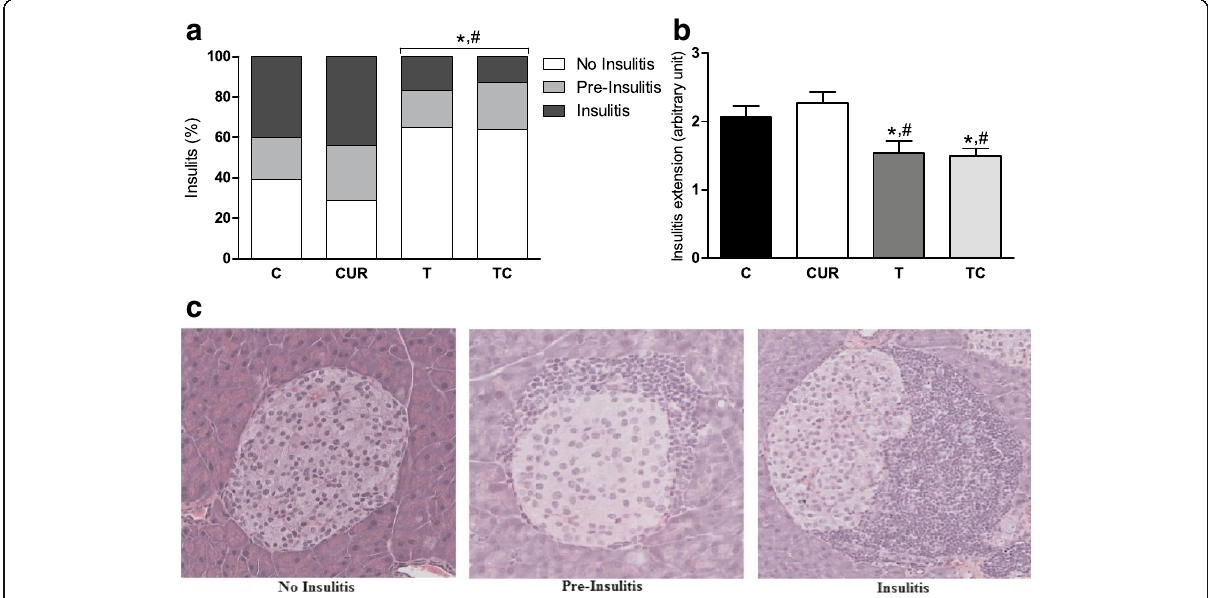
Fig. 2 Quantitative/representative analysis of insulitis. Insulitis distribution ( a ), insulitis extension ( b ), and representative image used to label insulitis level ( c ). Control ( C ), curcumin ( CUR ), trained ( T ), and trained + curcumin ( TC ).*Different from control; #different from curcumin